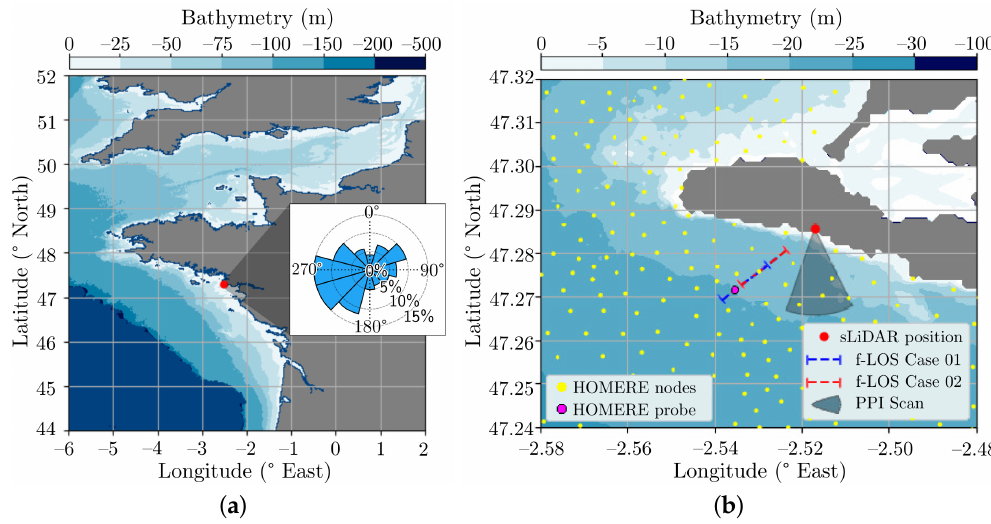
Figure 2. sLiDAR position denoted by a red dot and water depth displayed by the colormap. ( a ) Location of Le Croisic on the French west Atlantic coast. The wind rose for Le Croisic was taken from the Global Wind Atlas [59], covering the period 2008–2017. ( b ) View of Le Croisic peninsula, with the Plan Position Indicator (PPI) scans for WD determination in the black sector, and staring mode measurements’ lines (f-LOS) for Case 01 (blue) and Cases 02[a–c] (red) in dashed lines. Oceanic conditions were estimated from the HOMERE hind-cast database. The hind-cast grid is depicted by its nodes in yellow dots; probing was performed in the node depicted in